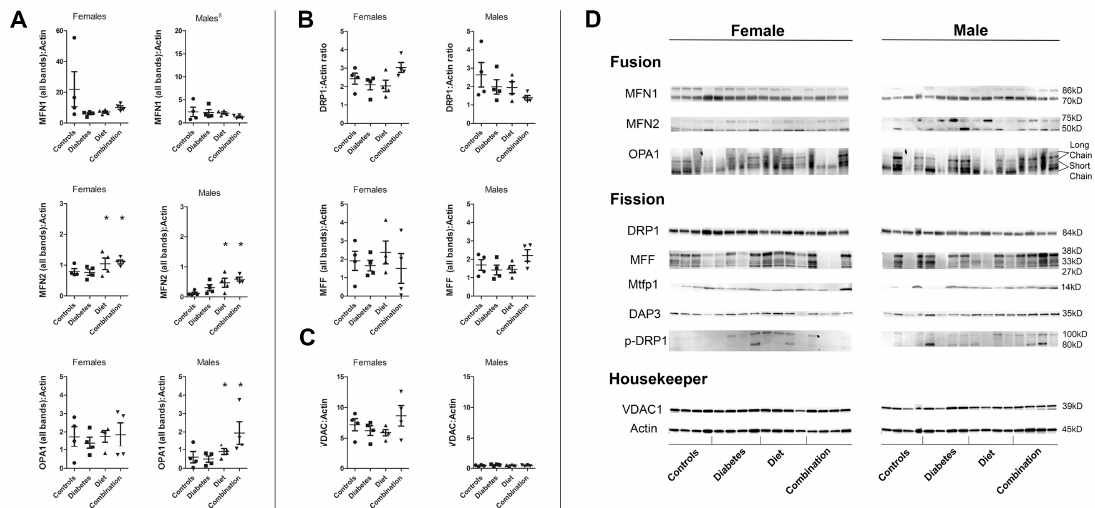
Figure 5. Maternal high-fat diet and diabetes influences cardiac expression of dynamism regulating proteins in a sex-specific manner. Whole heart protein was isolated and Western blot analysis was used to determine di ff erences in relative expression of ( A ) fusion proteins MFN1, MFN2, OPA1 and ( B ) fission proteins, DRP1 and MFF. Single data points represent individual female or male o ff spring from di ff erent litters. Bars represent median and interquartile range. Data points show relative expression compared to the reference protein, β -actin. Regardless of exposure, females had significantly higher expression of all fusion proteins. ( C ) Voltage-dependent anion channel or porin (VDAC) was used as an additional mitochondrial housekeeper. VDAC:actin did not vary between exposure groups, however relative expression of VDAC was 16-fold higher in female compared to male hearts, which suggests a higher number of well-charged mitochondria per sample. ( D ) Immunoblots are shown. Significant group di ff erences are annotated * for dietary e ff ect by two-way ANOVA; p ≤ 0.05. n = 4 males and 4 females /